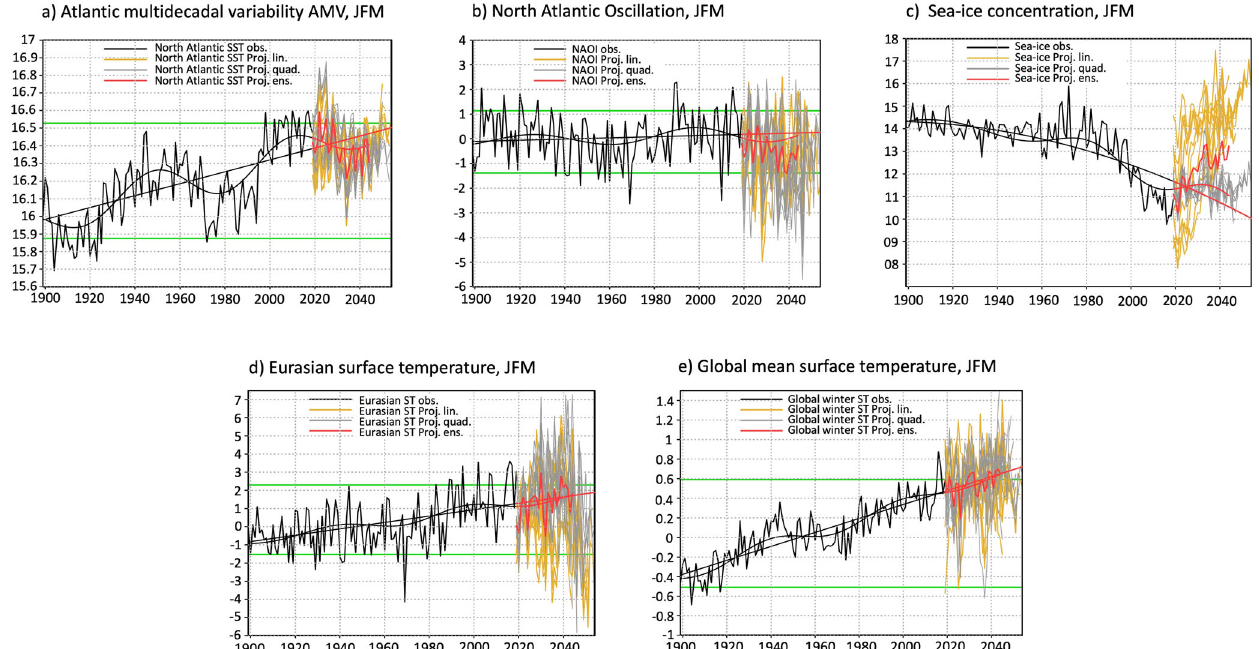
Fig. 7 Implication of the coupled atmosphere/ocean variability for the near-future climate. The non-normalized wintertime (JFM) indices of historical (black line) and ensemble projection (Methods) computed as: a averaged North Atlantic SST (over the same region as used for the AMV index in °C), b NAO index (standardized), c averaged Arctic sea-ice concentration (60° W – 50° E and 50 – 90° N, in %), d averaged Eurasian surface temperature (10° W – 130° E and 45 – 85° N, in °C), e global mean surface temperature (in °C). All projections were performed based on the observed coupled atmosphere/ocean variability using lagged multi-regression method (Methods). The future projections were fi rst performed on detrended data and the trends (that were extrapolated into the future) were added afterward. This allowed us to understand the interaction between the multidecadal fl uctuations and the long-term climate trends. Yellow lines represent predictions with sea-ice concentration index that was detrended using a linear trend, and the gray lines represent the predictions from the sea-ice that was detrended using a quadratic trend (Methods). The ensemble mean (red line) is computed from the individual members using both linear and parabolic approximations of sea-ice trend. The smooth black and red lines represent 50 – 70 year smoothing of the raw data. Horizontal green lines represent the 5 and 95%